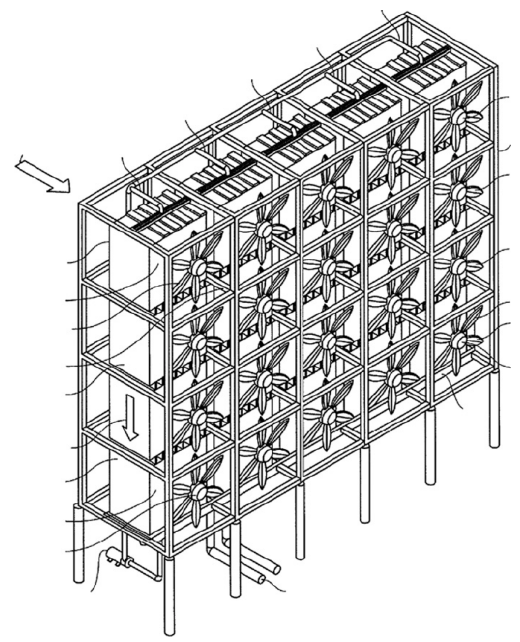
Figure 1. Schematic of the DAC device [26].